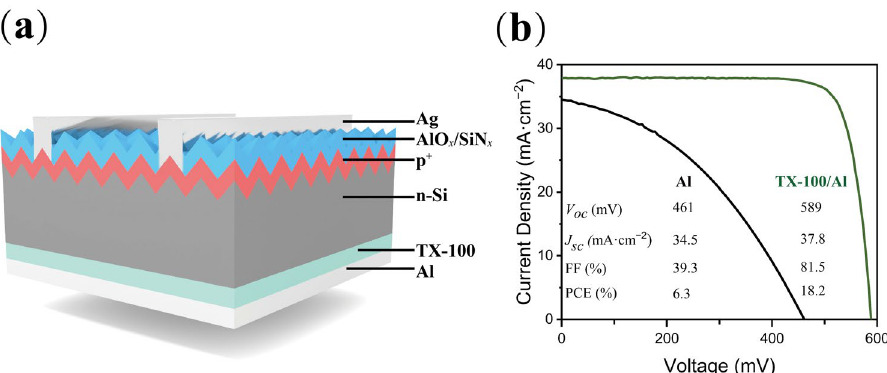
Figure 4. ( a ) Schematic of an n-type silicon solar cell with full-area TX-100/Al contact on the backside; ( b ) illuminated J−V curves without and with TX-100.